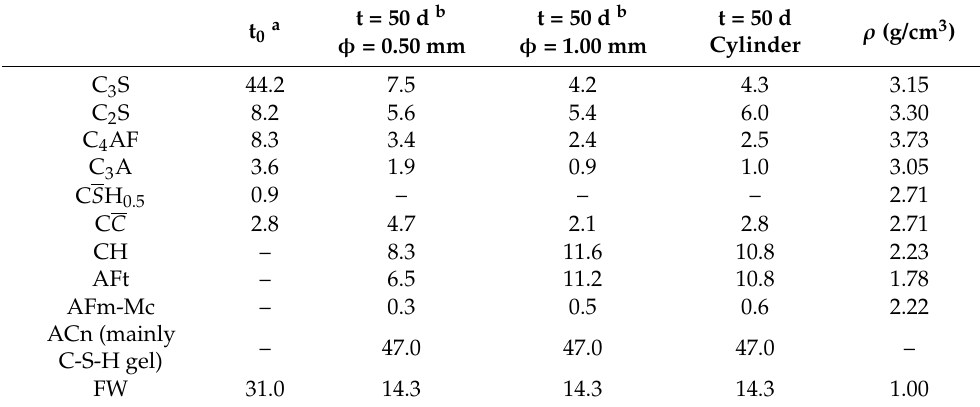
Table 1. Rietveld quantitative phase analysis (RQPA) results (wt%), including amorphous and crystalline non-quantified (ACn) and free water (FW) contents, for the w/c = 0.45 samples hydrated for 50 days at 20 ◦ C and referred to 100 g of paste. Mass density of each phase is also